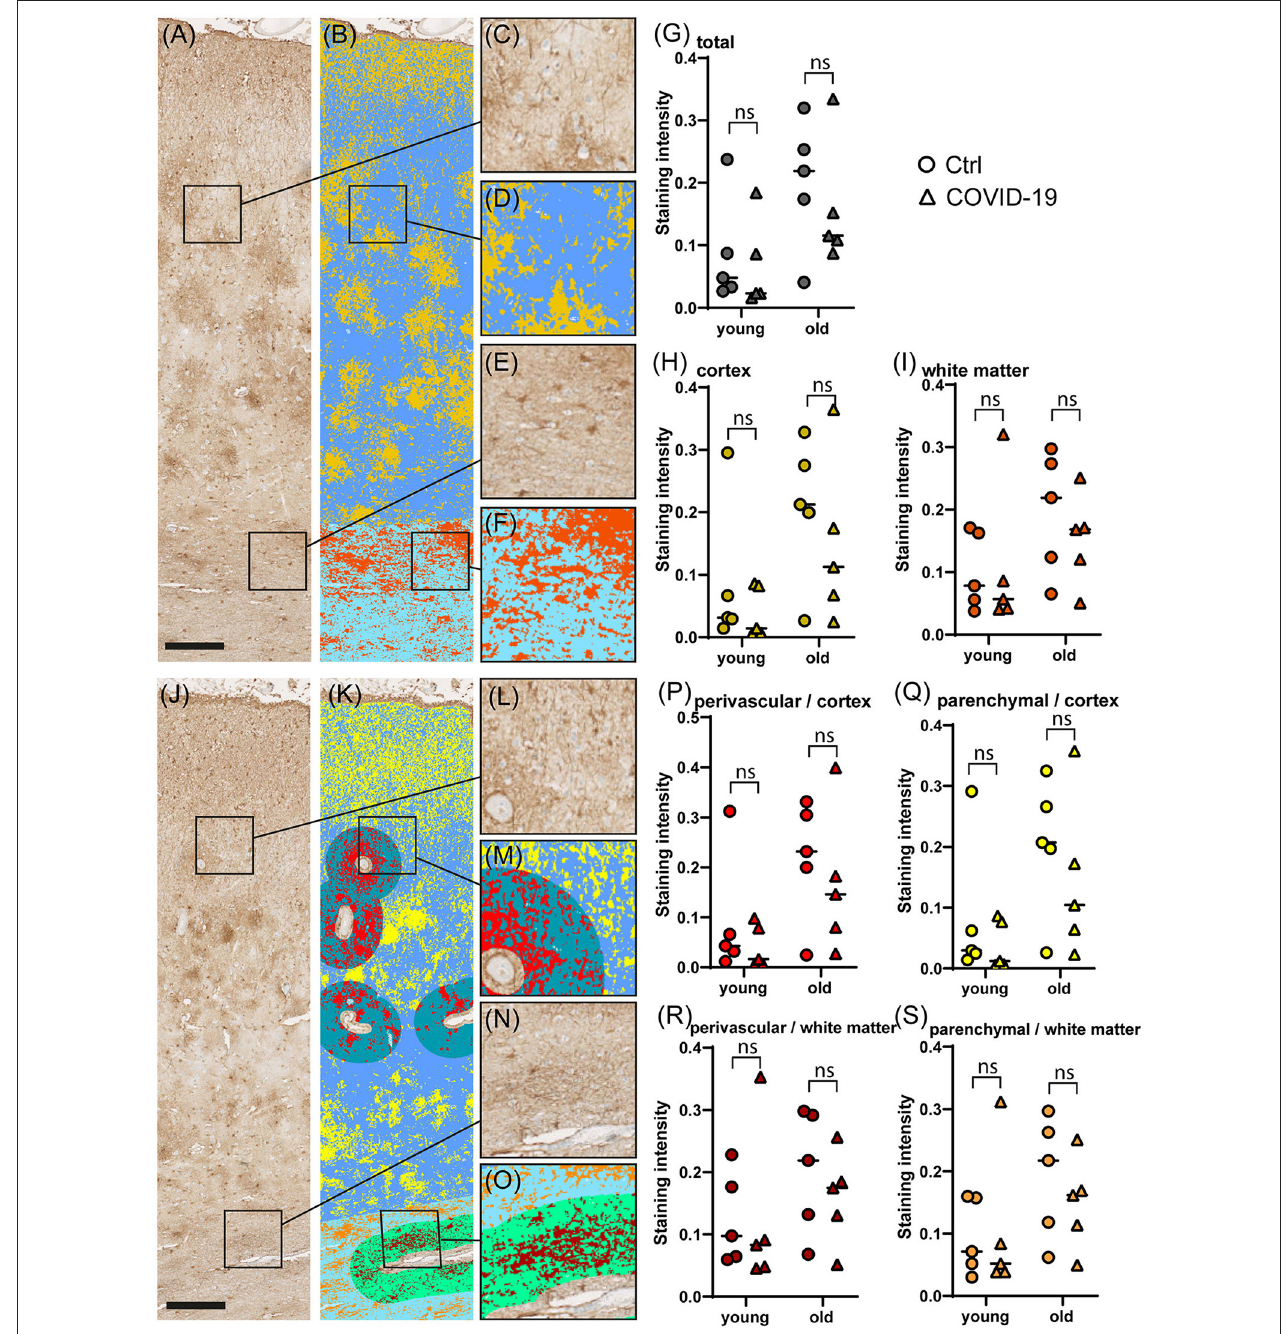
FIGURE 4 | Comparison of GFAP immunostaining in COVID-19 and control cerebral tissue stratified according to patient age. (A–F) Representative images of cerebral GFAP immunostaining (A) , comprising cortex (C) and white matter (E) . The colorized overlay image (B) indicates categorized pixel intensities in the cortex [ (D) , gold: DAB, blue: immunonegative tissue] and white matter [ (F) , orange: DAB, sky blue: immunonegative tissue]. Scale bar is 250 µ m. (G–I) Dot plots showing staining intensity ratios calculated from cerebral tissue in young ( < 60y) vs. old ( ≥ 90y) patients in total (G) , and separately in the cortex (H) and white matter (I) . (J–O) Representative image of cerebral GFAP immunostaining (J) , comprising cortex (L) and white matter (N) . The colorized overlay image (K) indicates categorized pixel intensities in perivascular regions of the cortex [ (M) , red: DAB, turquoise: immunonegative tissue] and parenchymal regions of the cortex [ (M) , yellow: DAB, blue: immunonegative tissue] as well as perivascular regions of the white matter [ (O) , mocha: DAB, light green: immunonegative tissue] and parenchymal regions of the white matter [ (O) , orange: DAB, sky blue: immunonegative tissue]. Scale bar is 250 µ m. (P–S) Dot plots showing staining intensity ratios in young ( < 60y) vs. old ( ≥ 90y) patients in cortical perivascular (P) and cortical parenchymal (Q) as well as perivascular white matter (R) and parenchymal white matter (S) regions. * p < 0.05, ns, not significant; n = 5 per group.